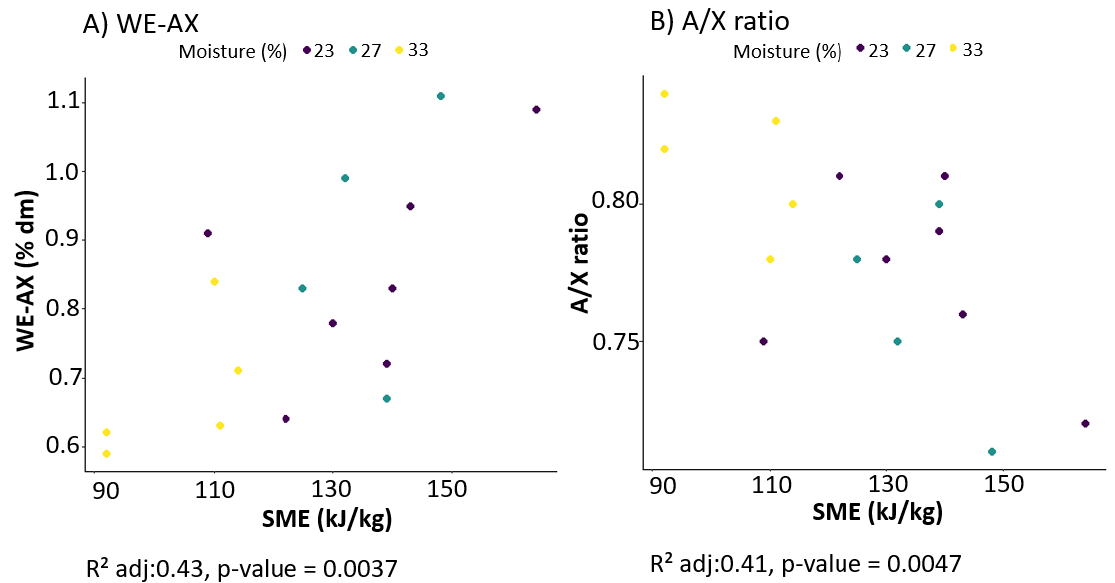
Figure 5. Scatterplot of ( A ) water-extractable arabinoxylan content (WE-AX) and ( B ) arabinose to xylose (A / X) ratio according to specific mechanical energy (SME). Data points are coloured according to moisture content during extrusion-cooking. Adjusted R 2 and p -values were obtained using the simple linear regression of WE-AX and A / X ratio as a function of SME.